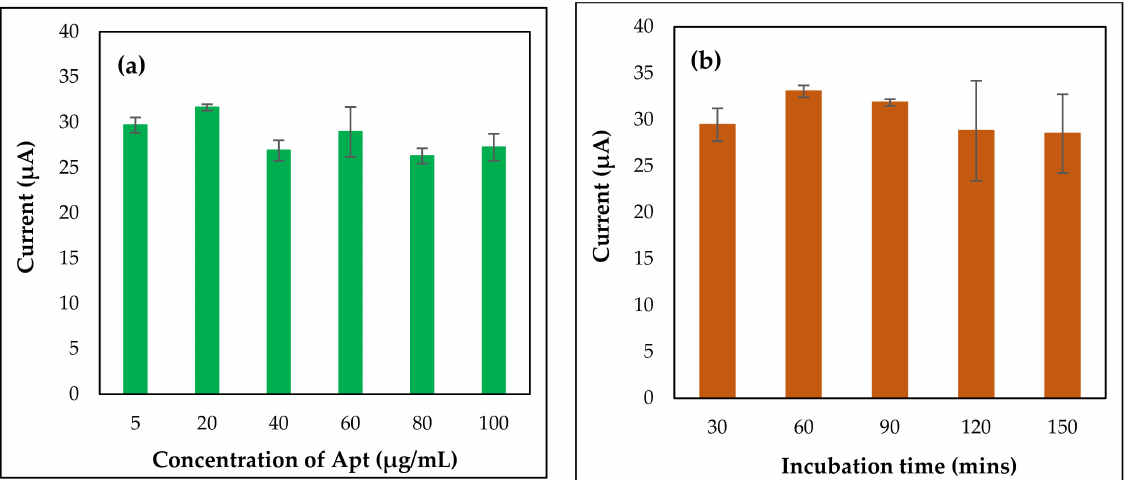
Figure 4. The effect of different concentrations ( a ) and immobilization time ( b ) of CapApt on the fabricated aptasensor in 0.1 M PBS at potential 0.0–1.0